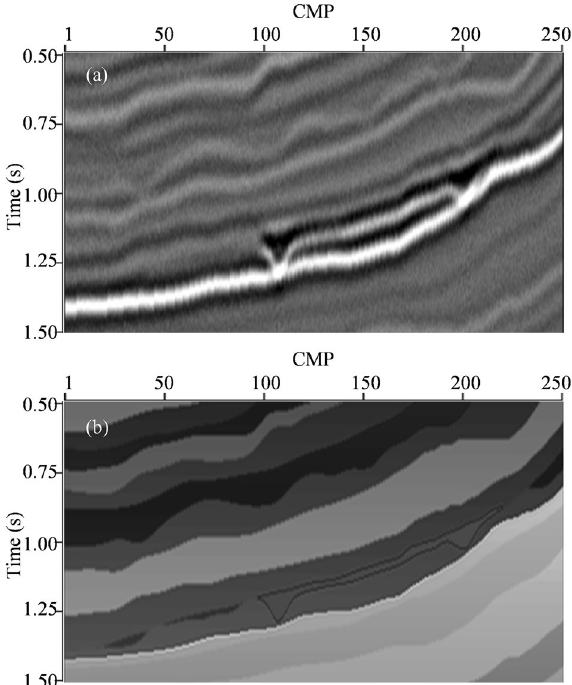
Figure 1. ( a ) Noise-tainted synthetic seismic data section. ( b ) The true 2D impedance model section.